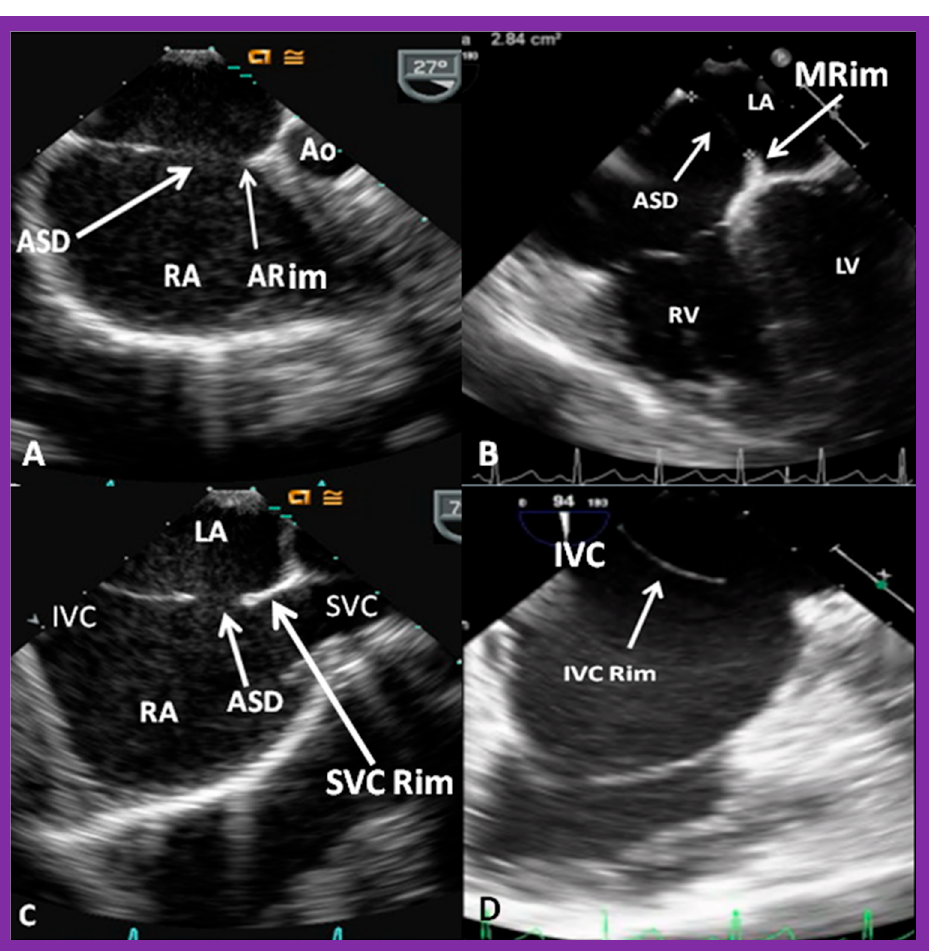
Figure 20. Transesophageal echocardiographic studies of the atrial septum demonstrating aortic (ARim), mitral (MRim), superior vena caval (SVC Rim), and inferior vena caval (IVC Rim) rims in sort-axis ( A ) four-chamber ( B ), and bi-caval ( C , D ) views, respectively. Aorta (Ao), atrial septal defect (ASD), inferior vena cava (IVC), left atrium (LA), left ventricle (LV), right atrium (RA), right ventricle (RV), and superior vena cava (SVC) are labeled.